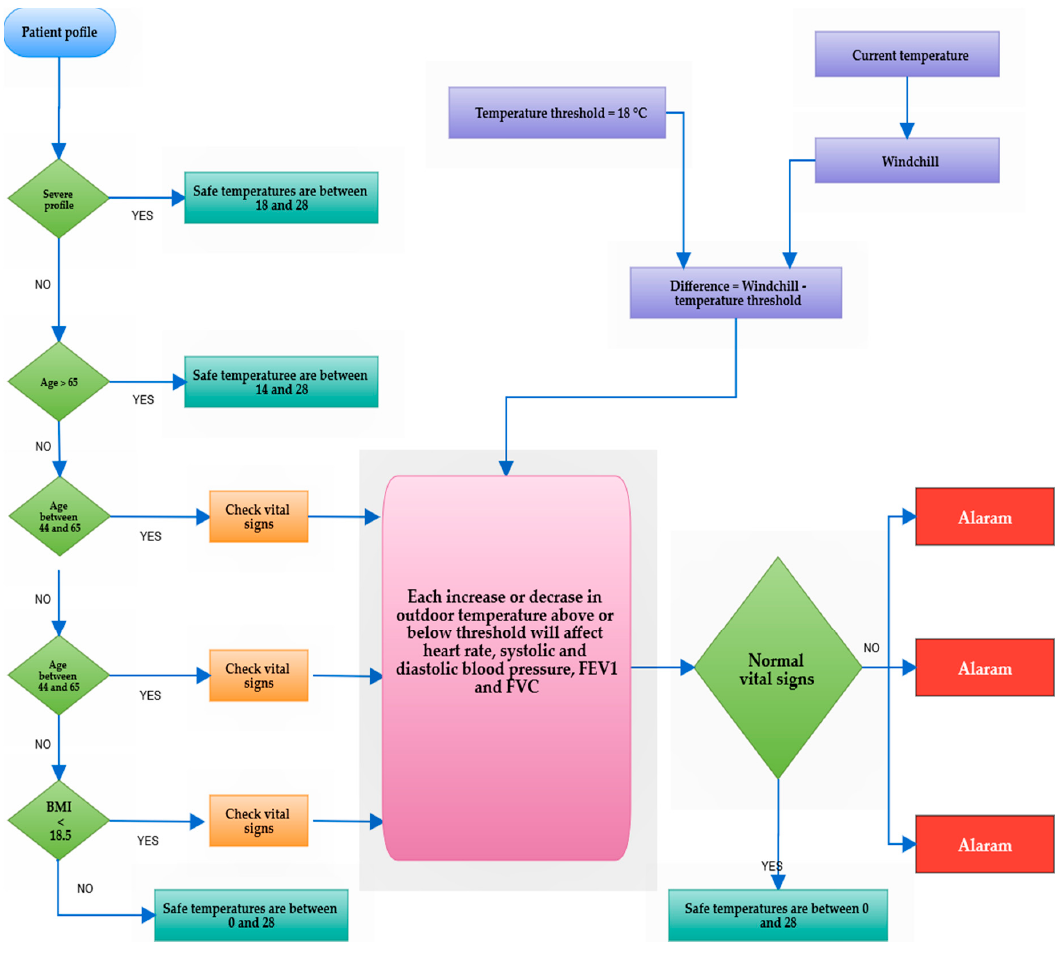
Figure 5. Outdoor temperature rules .